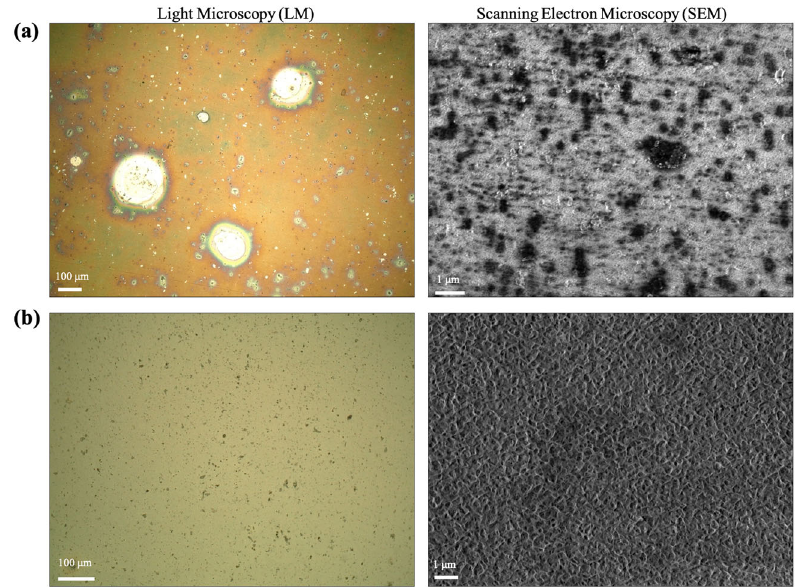
Fig. 6 Surface morphology of the AA sample exposed to different amount of 0.01 M NaCl + 0.01 M Li 2 CO 3 solution for 7 h. LM and SEM images of the conversion layer formed at the batch condition of the solution volume/exposed surface area ratio of: a 4 mL cm − 2 and ( b ) 0.2 mL cm − 2